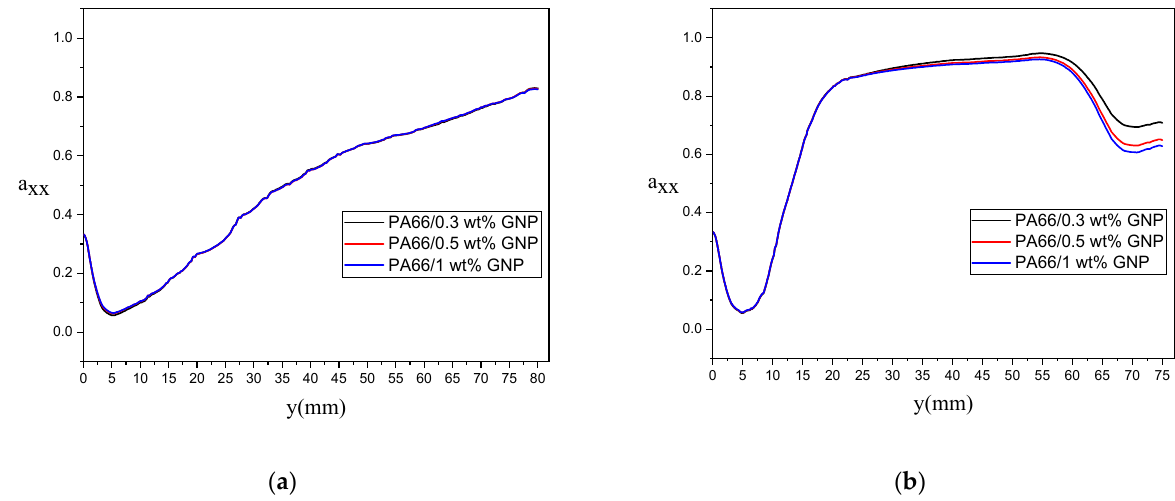
Figure 16. Evolution of a xx along the central streamline (symmetry line) for different GNPs wt%: ( a ) for rectangular and ( b ) dog bone samples.